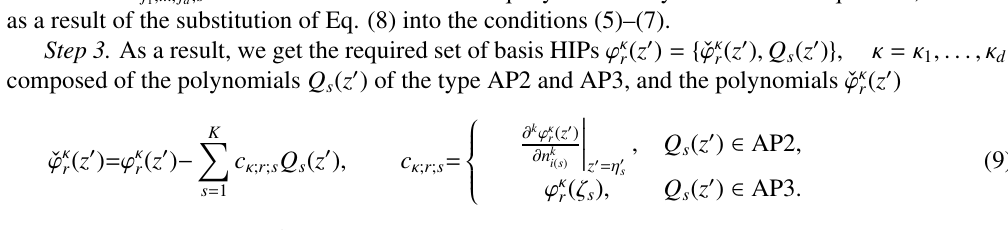
coordinate axes, are recalculated using Eqs. (1) into ˇ ϕ ˇ κ ˇ κ = ˇ κ 1 , . . . , ˇ κ d denotes the directional derivatives along the physical coordinate axes. For example, at d = 2 the derivatives ∂/∂ n i along the direction n i , perpendicular to the appropriate face i = 0 , 1 , 2 in the physical frame are expressed in terms of the partial derivatives ∂/∂ z (cid:31)